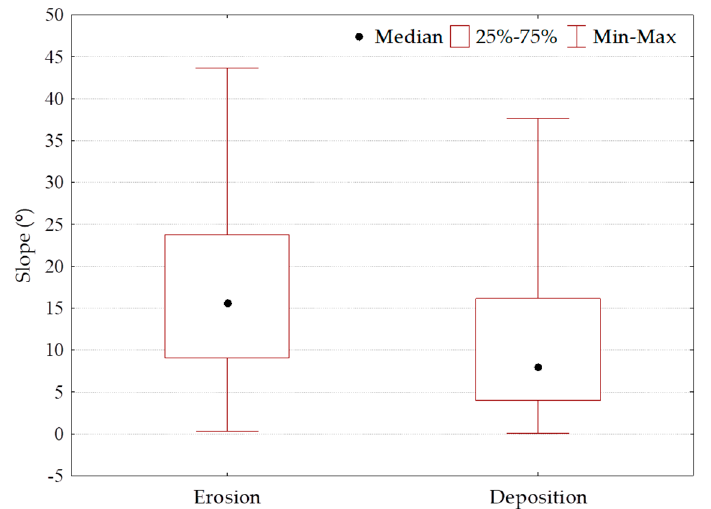
Figure 15. Initial slope gradient (calculated using the DEM from 2016) for pixel that experienced erosion or deposition from 2016 to 2019 ( p < 0.05).